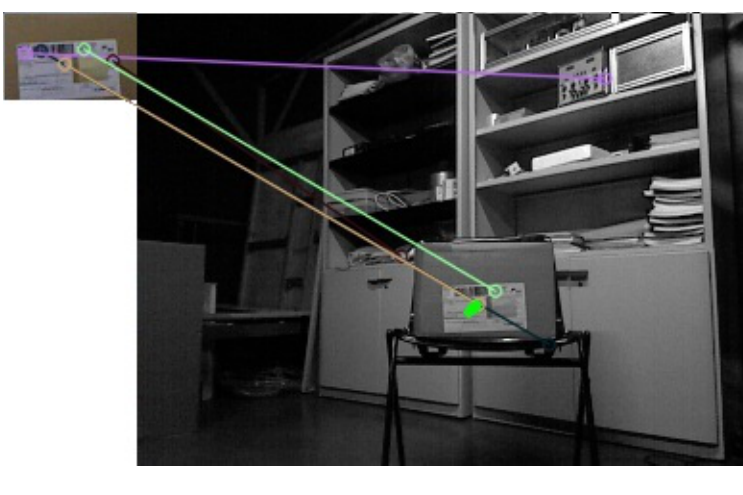
Figure 7. Model descriptors matching an